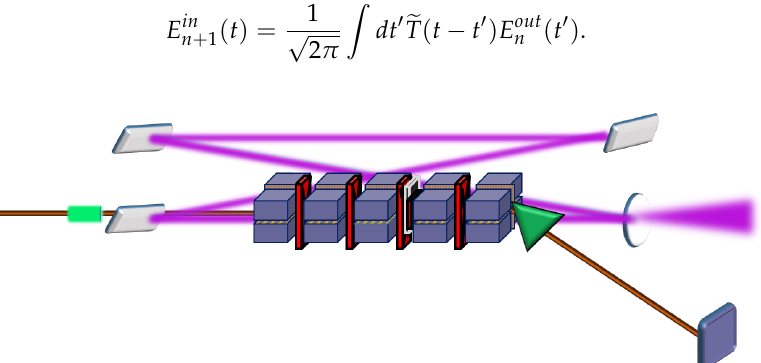
Figure 7. Regenerative Amplifier with three diamond mirrors and one beam splitter operating at different wavelengths.